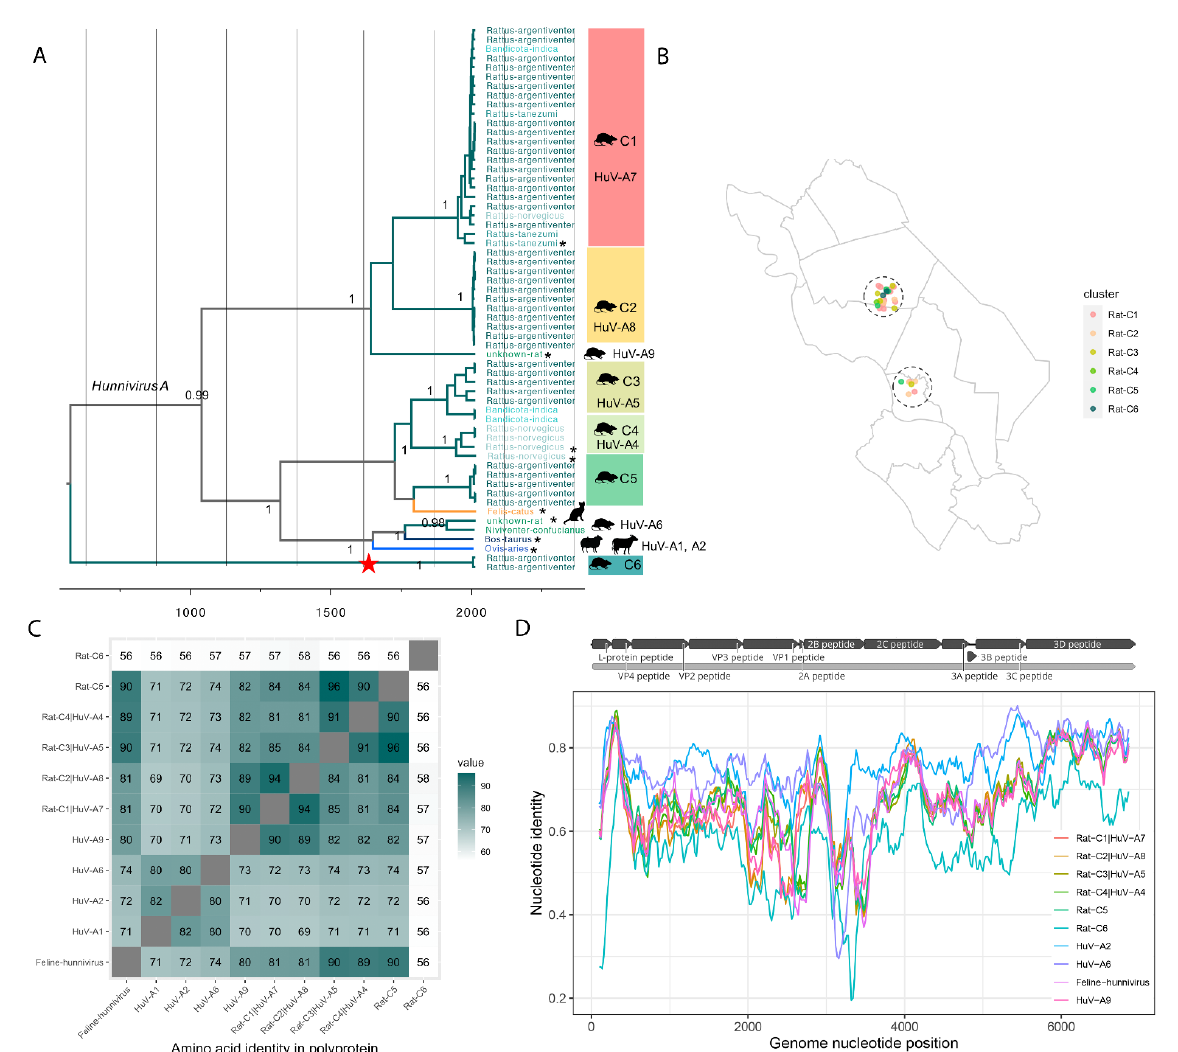
Figure 5. Hunnivirus sequences in rats and other hosts. ( A ) Simplified MCC tree representing the time-scale phylogeny of hunniviruses. Bayesian time-scaled tree of VP1 sequences detected in Vietnamese rats and reference sequences in NCBI (highlighted in asterisk). Different host species are labelled on the tips and distinct by colours and symbols (rat in different shades of green, cat in orange, bovine and ovine in dark blue); the six clusters found in Vietnamese rats (Rat-C1-C6) are labelled on the right; the internal node of Rat-C6, a putative member of a novel species, is highlighted with red star. ( B ) Locations of rat samples with hunniviruses, coloured by different clusters identified in the phylogenetic tree. ( C ) Amino acid identities of polyprotein among rat clusters and other hosts. ( D ) Nucleotide distance scan across the polyprotein coding region of rat clusters (Rat-C1 to C6) against HuA-A1 and comparing to other known hunnivirus types.